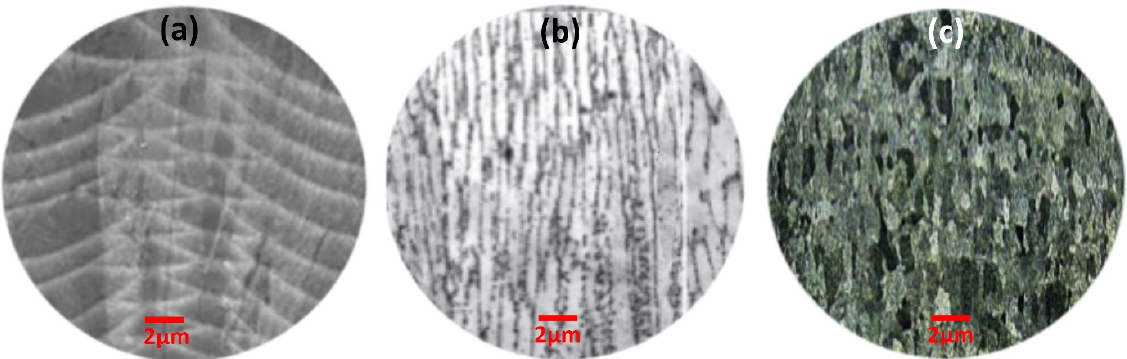
Figure 18. ( a ) Fish-scale morphology due to repeated heating and cooling, ( b ) epitaxial growth of the microstructure as observed in DED, and ( c ) equiaxial grain regions found in SLM.